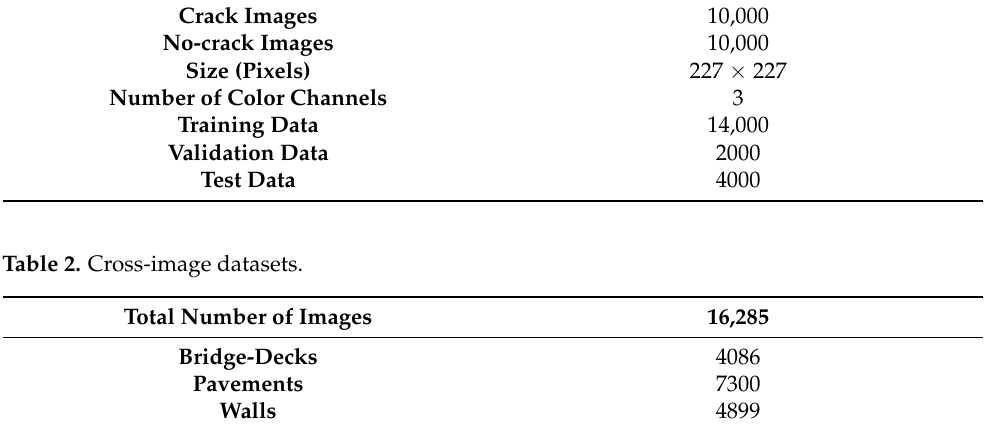
Table 1. Concrete crack image datasets.